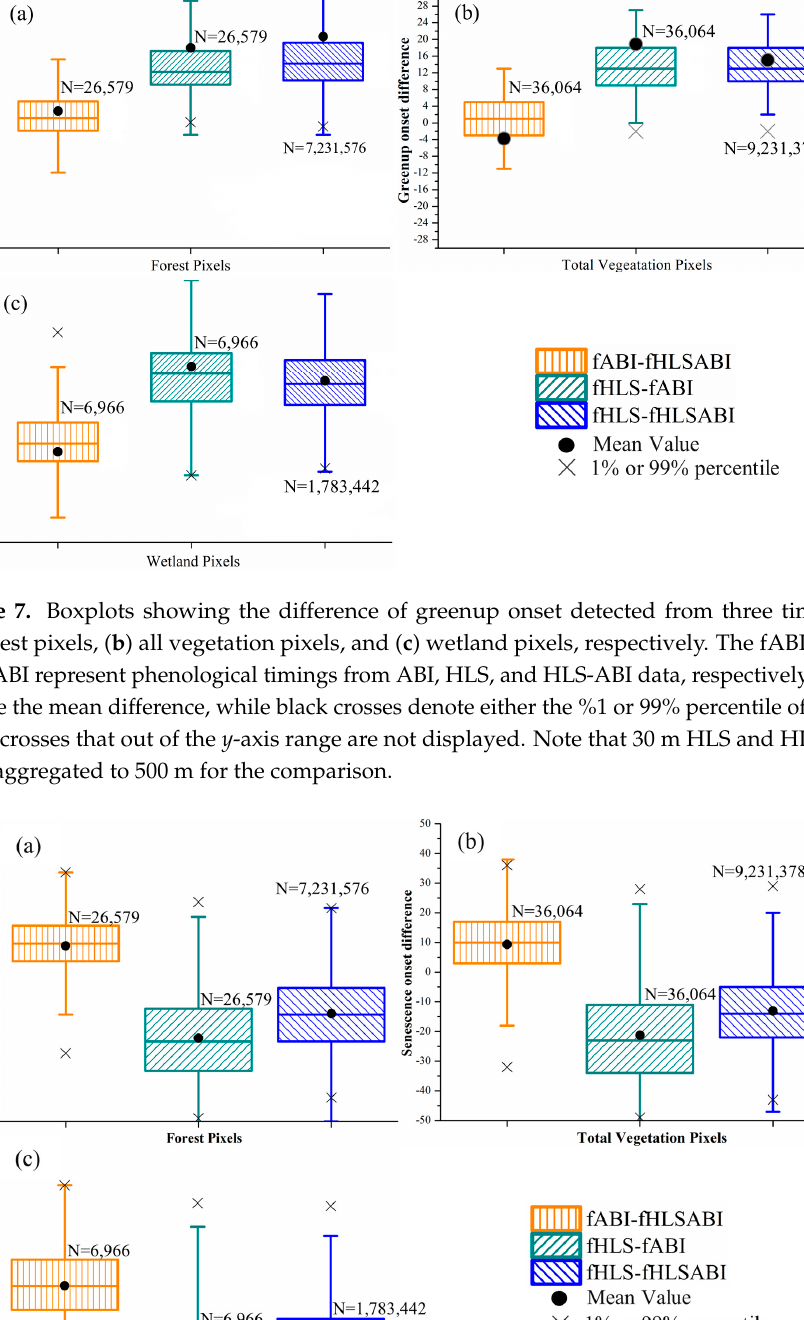
Figure 8. Boxplots showing the difference of senescence onset detected from three time series in ( a ) forest pixels, ( b ) all vegetation pixels, ( c ) wetland pixels, respectively. The fABI, fHLS, and fHLSABI represent phenological timings from ABI, HLS, and HLS-ABI data, respectively. Black dots denote the mean difference, while black crosses denote either the %1 or 99% percentile of differences. Black crosses that out of the Y-axis range are not displayed. Note that 30 m HLS and HLS-ABI data were aggregated to 500 m for the comparison.